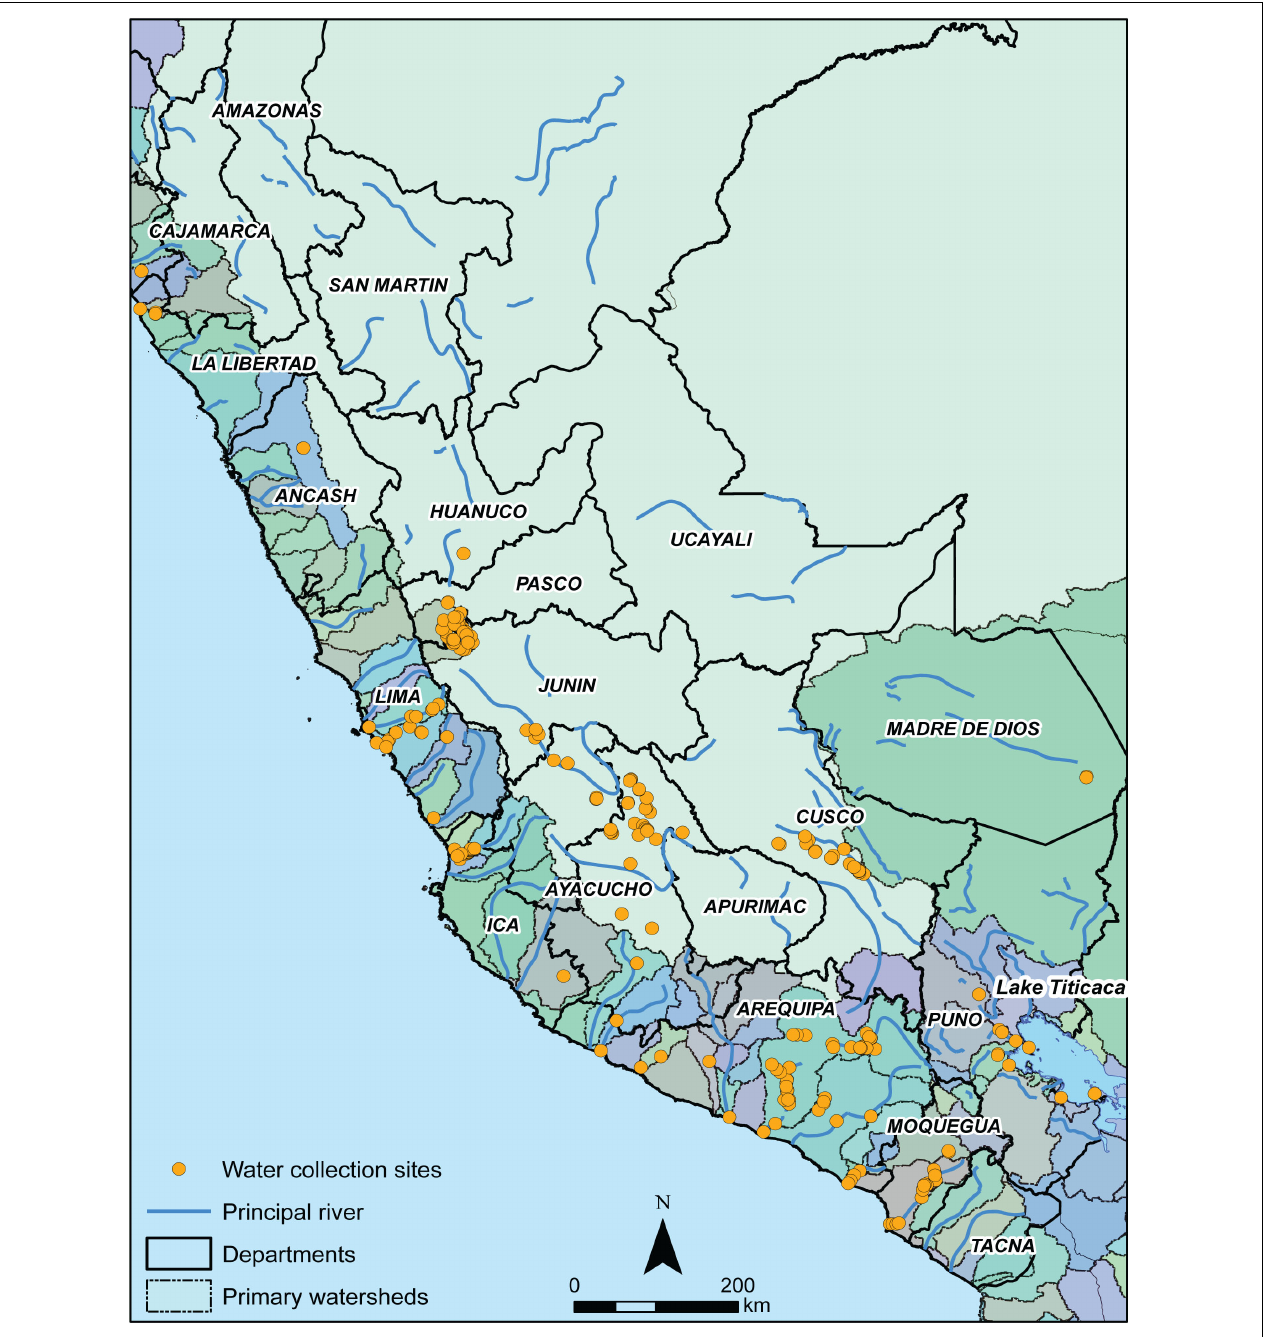
FIGURE 2 | Water sampling locations ( n = 262) throughout Peruvian departments (labeled with solid outline) relative to principal rivers and primary watersheds (colored fill with dashed outline).